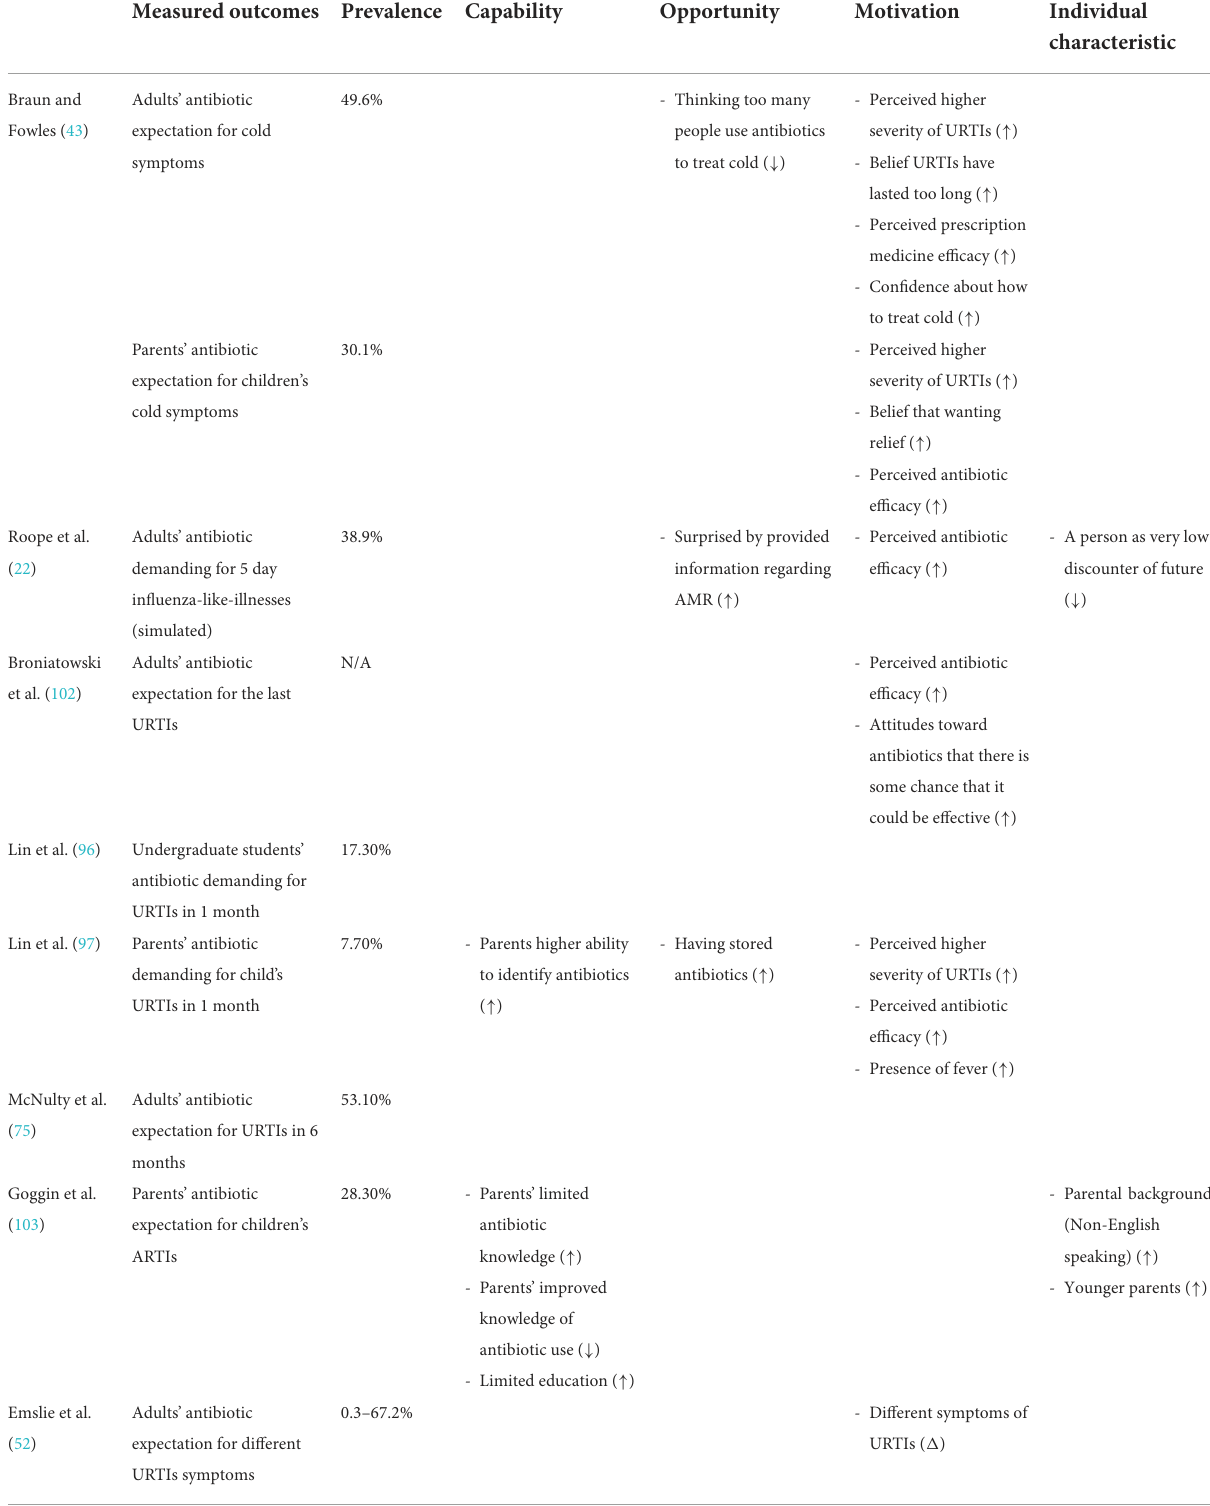
TABLE 3 The public’s antibiotic expectation behaviors for URTIs and its influencing factors. Study Behaviors Measured outcomes Prevalence